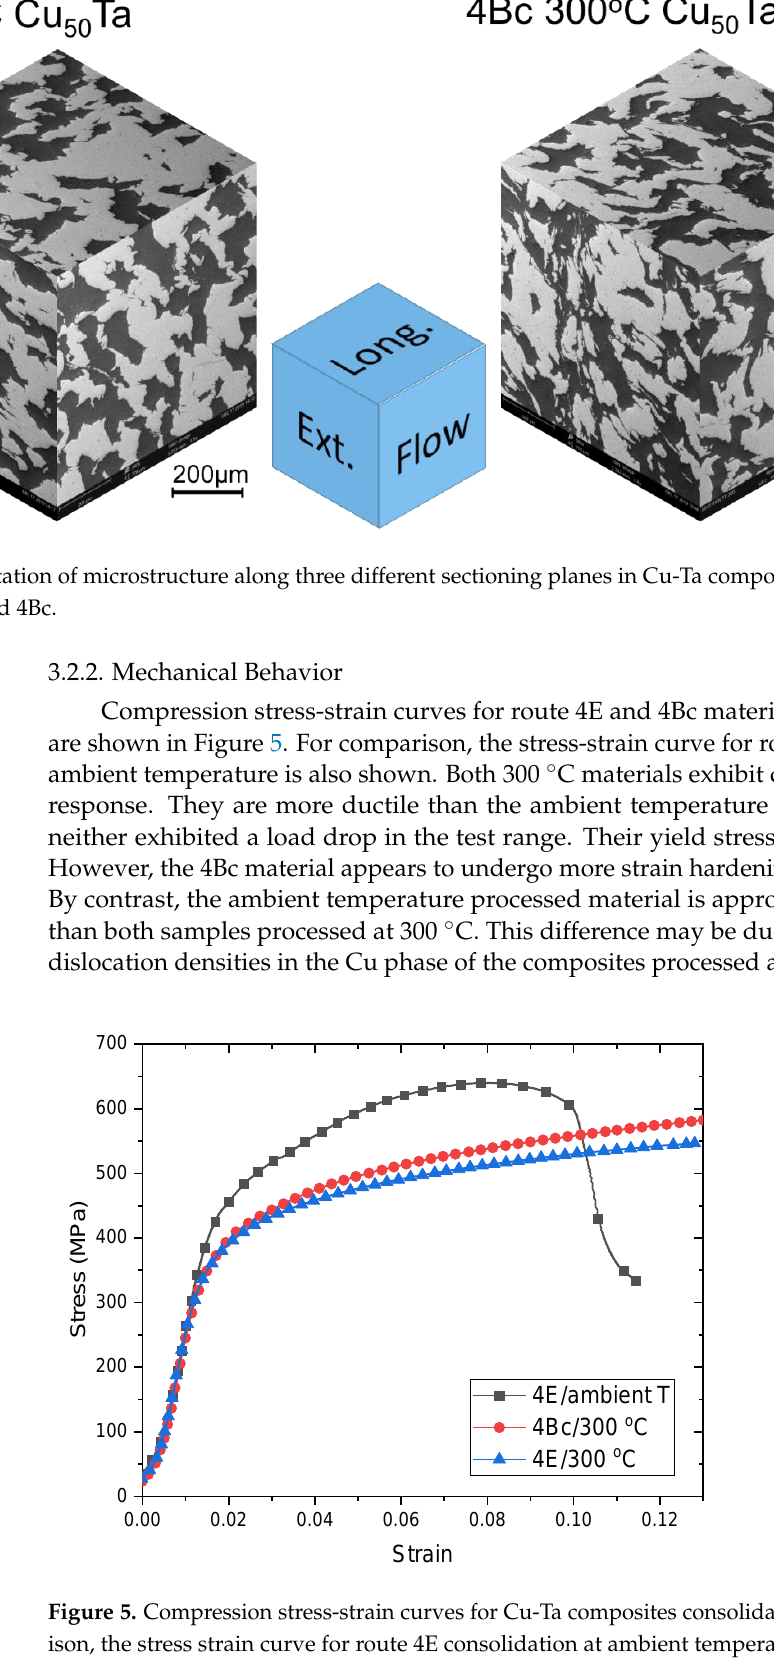
0.00 Figure 6. Compression stress-strain curves for Cu-Ta composites consolidated at 300 °C for tests along the extrusion di- rection (ED), longitudinal direction (LD), and flow direction (FD), ( a ) by route 4E, and ( b ) by route 4Bc. To assess strain rate sensitivity, the 300 °C -processed composites were further tested under two additional strain rates along the extrusion direction (ED): 10 −2 /s and 10 −1 /s. Cor- responding stress-strain curves are shown in Figure 7. A summary of the results for all testing directions and strain rates is shown in Table 3. The strain rate sensitivity exponent